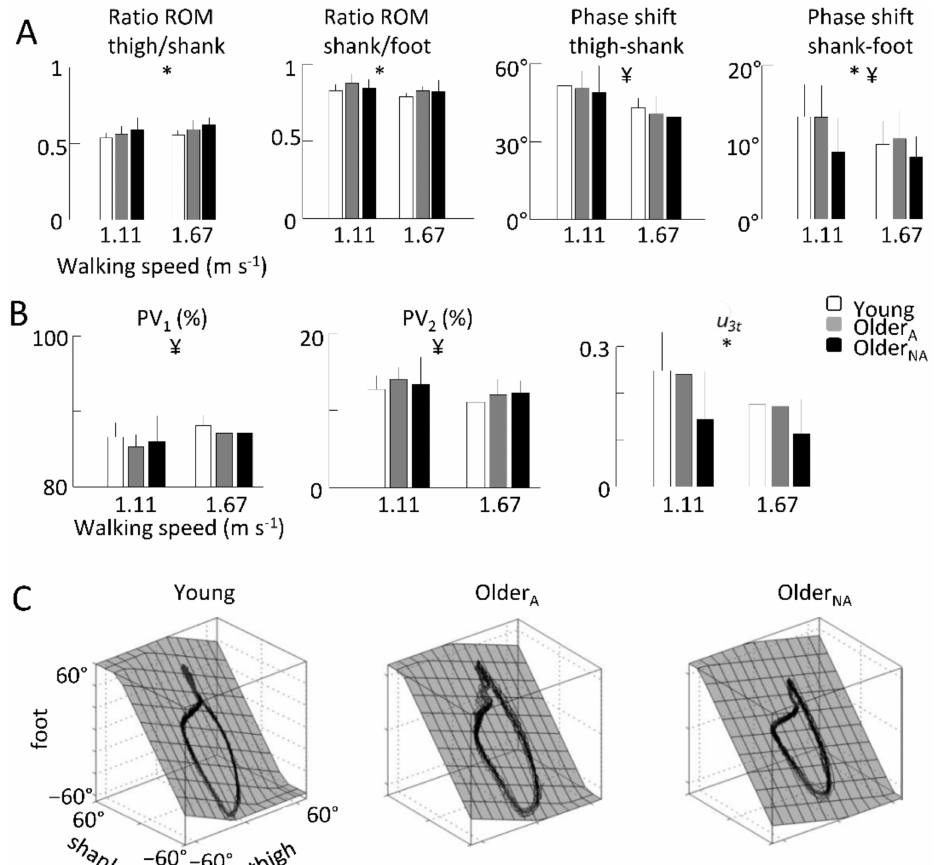
Figure 3. Intersegmental coordination. ( A ) Ratio between the range of motion of thigh and shank segments, shank and foot segments, phase shift between the first harmonic of thigh and shank and shank and foot elevation angles. ( B ) Percentage of variance accounted for by the first (PV 1 , left) eigenvector; the second (PV 2 , middle) eigenvector of the principal component analysis and the orientation of the principal plane (right), defined by the direction cosines of the normal to the covariation plane with the positive semi-axis of the thigh angular coordinates ( u 3t ). ( C ) Covariation of the limb-segment elevation angles during walking at 1.11 m s − 1 in the three groups. For each group, all the strides of one typical subject per group were plotted. Note that when the elevation angles of thigh, shank and foot are plotted one versus the other in a x-y-z space, and they co-vary along a loop constrained on a plane (x–y). Grids show the best-fitting plane. The symbols * and ¥ indicate a significant effect of age and speed, respectively. Other indications as in Figure